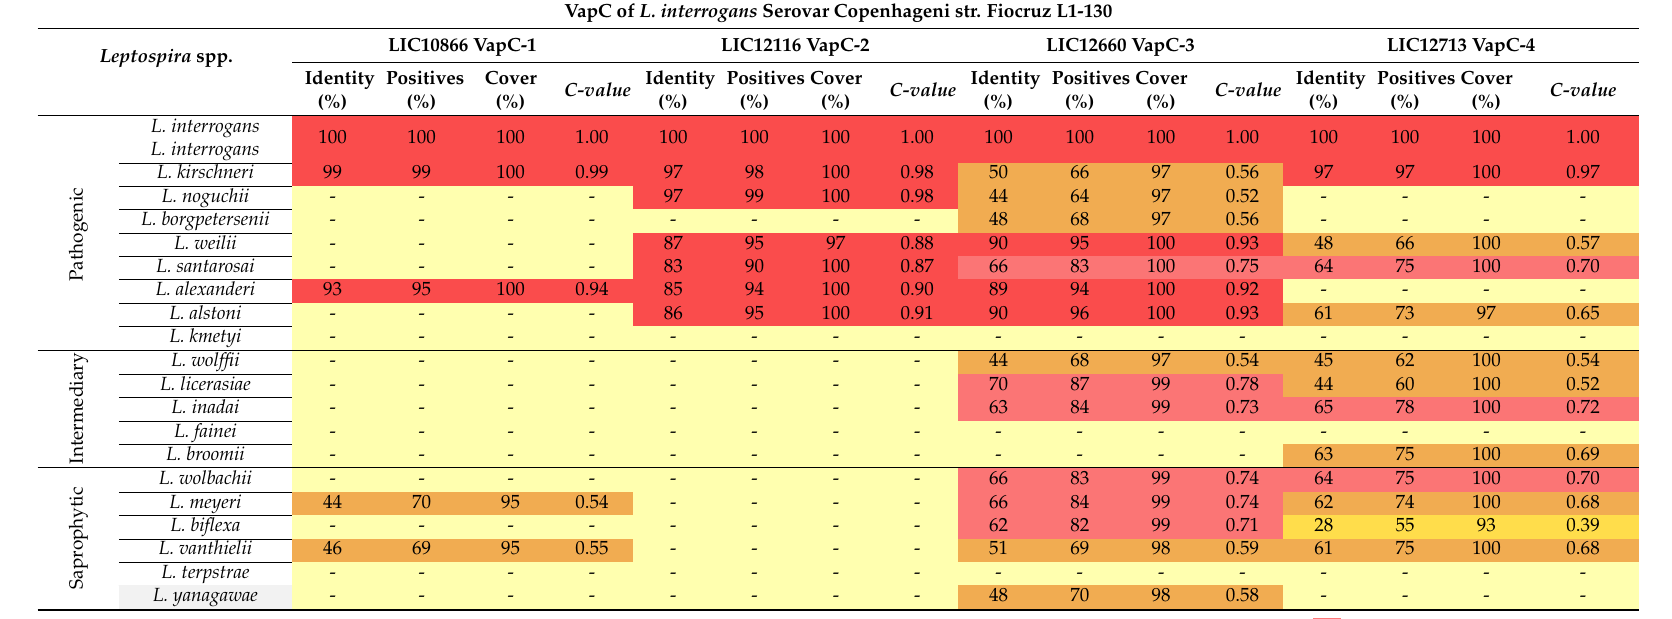
Table 2. Basic Local Alignment Search Tool (BLAST) analysis of VapCs of L. interrogans serovar Copenhageni Fiocruz L1-130. VapC of L. interrogans Serovar Copenhageni str. Fiocruz L1-130 Leptospira spp.